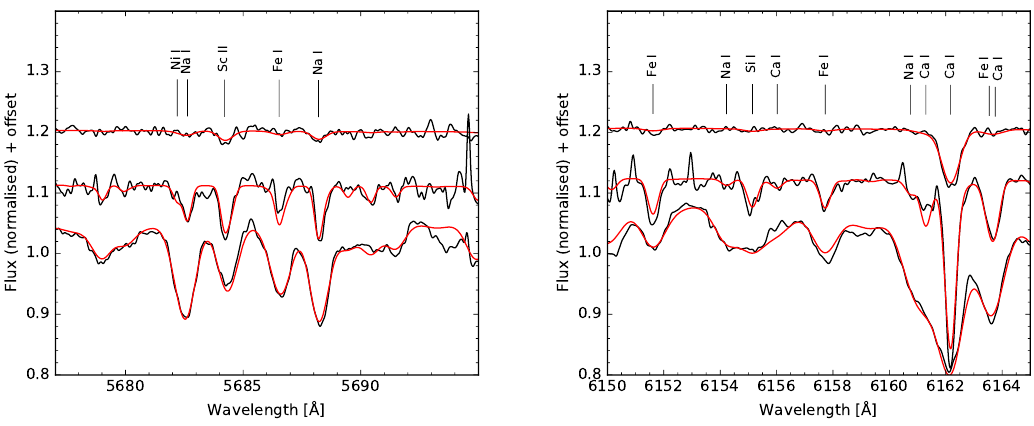
Figure 1. Fits to integrated-light spectra of the Galactic GCs NGC 7078 ( top ), NGC 6254 (centre), and NGC 6388 ( bottom ) for the regions near the Na I doublets at 5683/5688 Å ( left ) and 6154/6161 Å ( right ). From this type of fit, we can measure the abundances of many individual elements (e.g., Fe, Na, Mg, Ca, Sc, Ti, Cr, Mn, and Ba). From [21]. Credit: Søren S. Larsen, A&A, 601, A96, 2017, reproduced with permission c (cid:13)